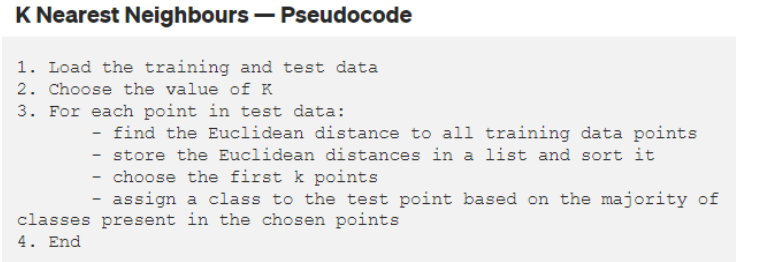
Figure 3. kNN algorithm.